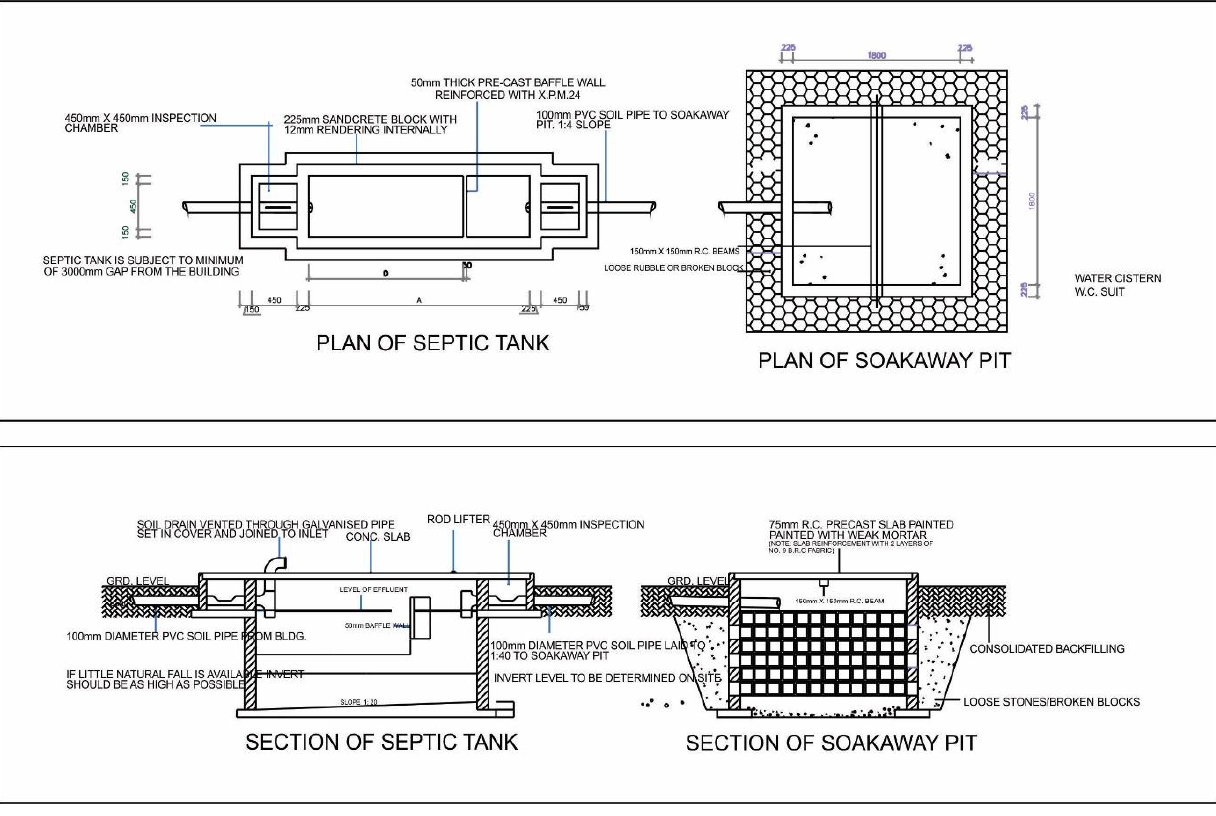
Fig. 3. Plans and sections of a typical Septic tank and Soakaway pit in Nigeria. Source: Author’s Archives.